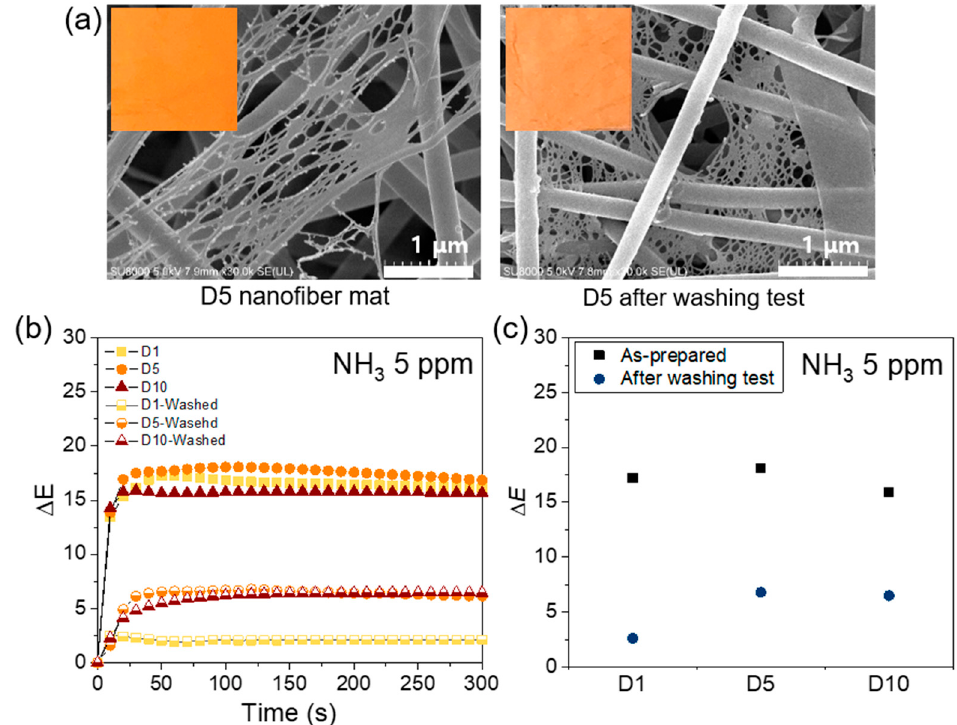
Figure 8. ( a ) FE-SEM image and optical image of the meta-aramid / dye 3 (D5) nanofiber before and Figure 8. (a) FE-SEM image and optical image of the meta-aramid/dye 3 (D5) nanofiber before and after washing test, ( b ) the time-dependent ∆ E values of the washed meta-aramid / dye 3 nanofiber after washing test, ( b ) the time-dependent Δ E values of the washed meta-aramid/dye 3 nanofiber sensor compared to that of as-prepared sample, and ( c ) the maximum ∆ E values of the washed sensor compared to that of as-prepared sample, and ( c ) the maximum Δ E values of the washed meta- meta-aramid / dye 3 nanofiber compared to that of as-prepared aramid/dye 3 nanofiber compared to that of as-prepared sample. Table 2. List of nanofiber-based colorimetric sensor for the NH 3 detection.